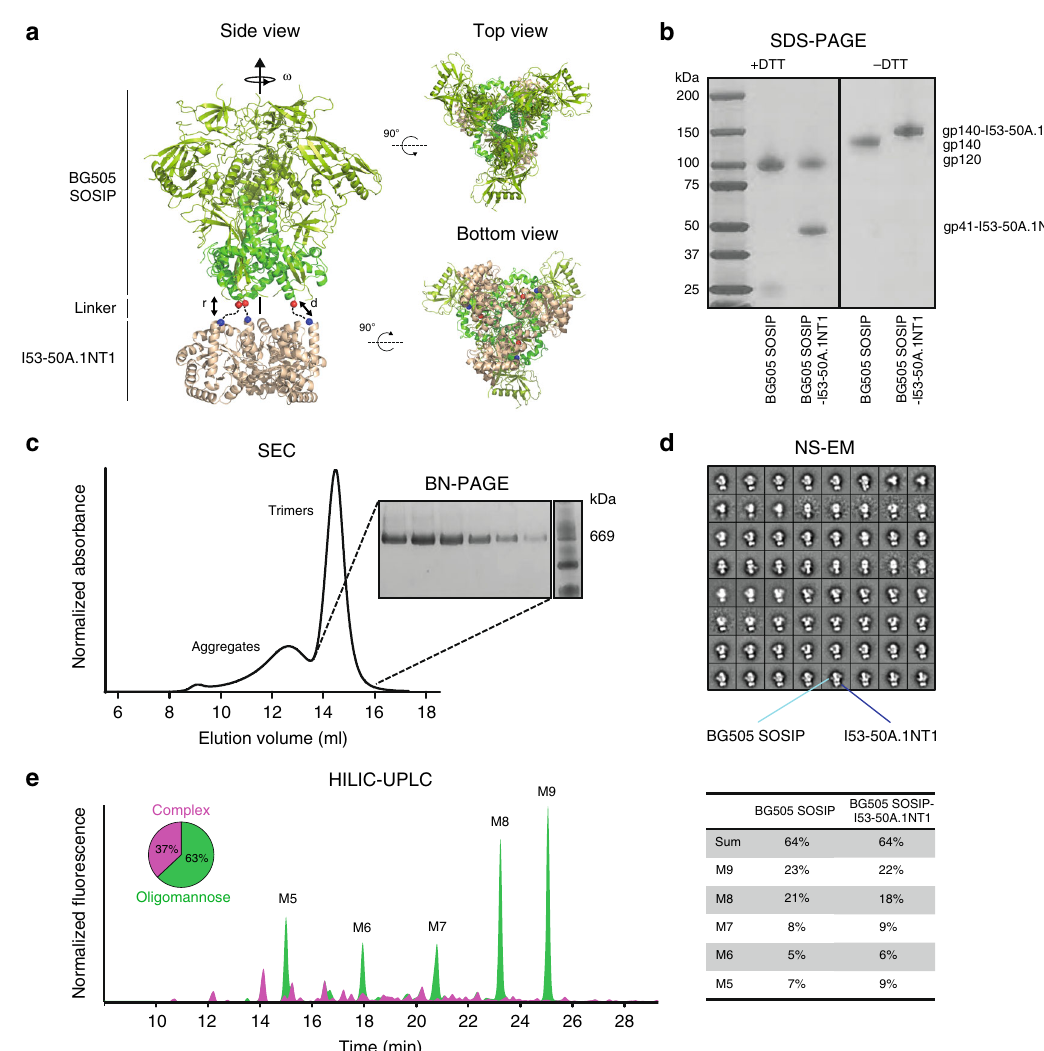
Fig. 1 Design and biophysical properties of BG505 SOSIP-I53-50A.1NT1. a Schematic representation of the computational docking protocol used to identify trimeric NP components suitable for fusion to BG505 SOSIP. r and ω were sampled during docking to minimize d while avoiding clashes. The C termini of BG505 SOSIP and N termini of the I53-50A trimer are shown as red and blue spheres, and the dashed line indicates the linker that connects BG505 SOSIP and I53-50A. b Sodium dodecyl sulfate-polyacrylamide gel electrophoresis (SDS-PAGE) of BG505 SOSIP and BG505 SOSIP-I53-50A.1NT1 under reducing (left) and non-reducing (right) conditions. c SEC chromatogram of BG505 SOSIP-I53-50A.1NT1 with peaks corresponding to aggregates and trimers annotated (left) and blue native (BN)-PAGE of trimer fractions (right). d NS-EM analysis of PGT145/SEC-puri fi ed BG505 SOSIP-I53-50A.1NT1 with BG505 SOSIP (light blue) and I53-50A.1NT1 (dark blue) annotated. Shown are 2D-class averages. e Glycan pro fi le of BG505 SOSIP-I53-50A.1NT1 as determined by HILIC-UPLC with complex glycans in pink and oligomannose glycans in green. The pie chart represents the percentage of total complex glycans vs. oligomannose glycans per trimer. The percentages of Man 5-9 GlcNAc 2 glycans (M5 – M9) are listed in the table for BG505 SOSIP and BG505 SOSIP-I53- 50A.1NT1. Source data are provided as a Source Data fi